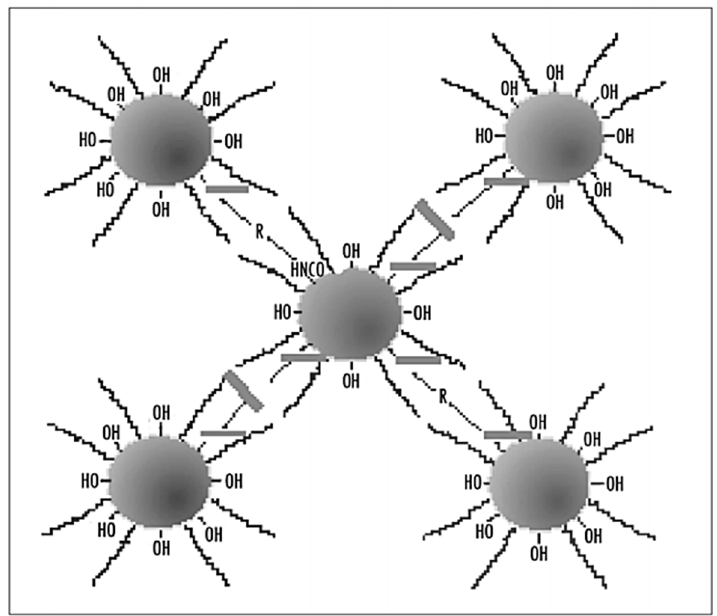
Figure 8. Schematic illustration of hyper-branched polyurethane dispersion. From reference [39].